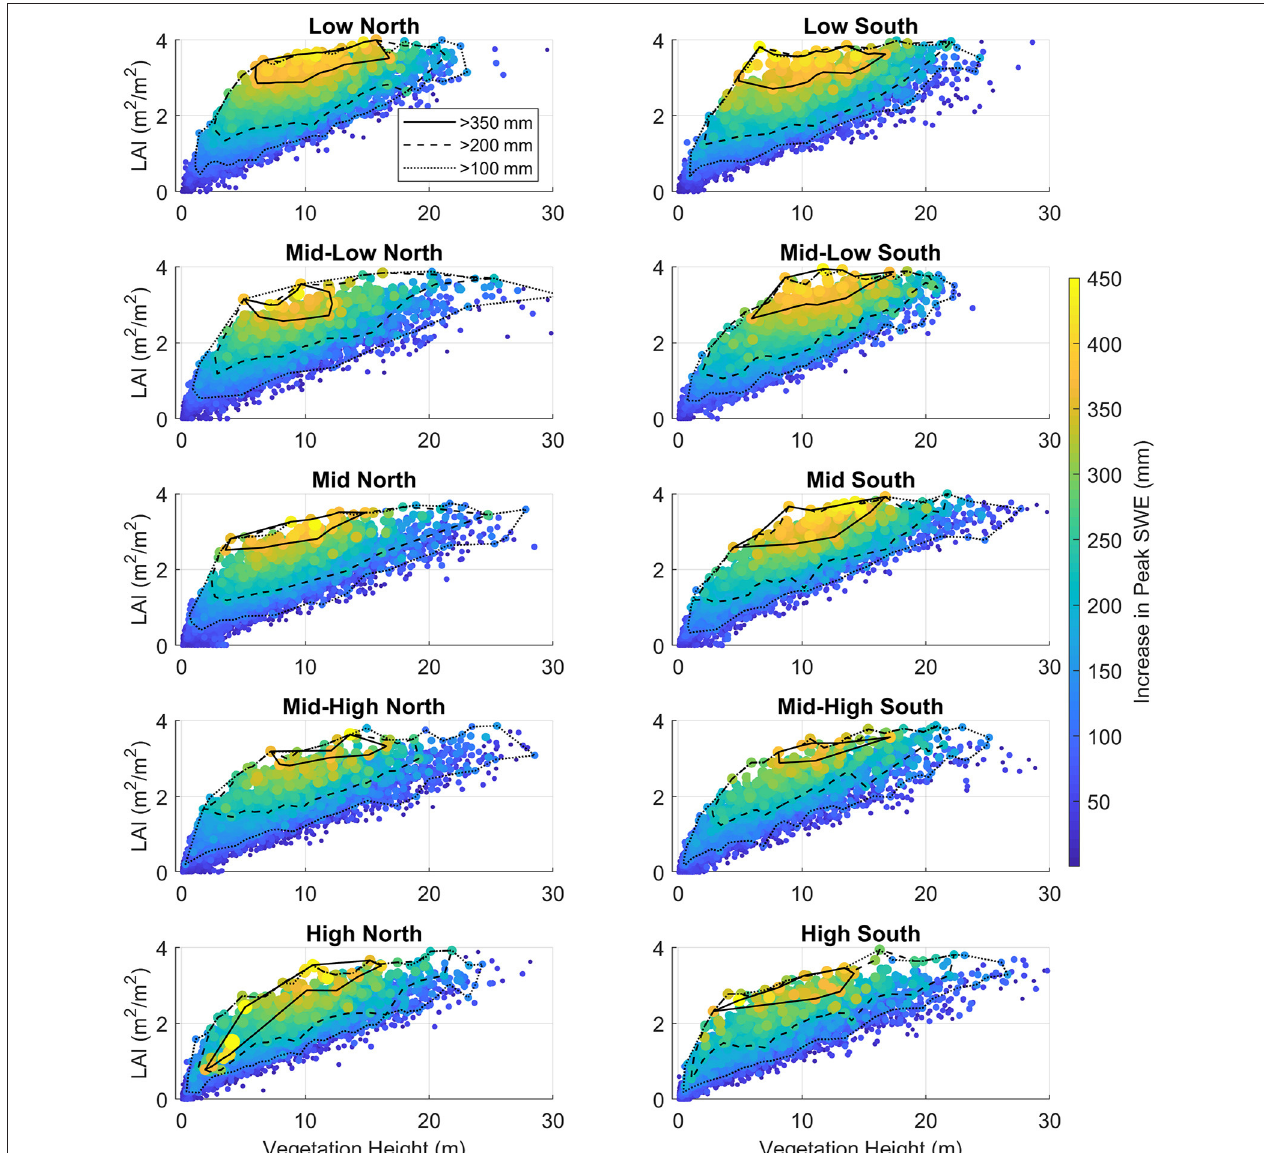
FIGURE 7 | Forest patch (30m) increase in peak SWE across Snow Zones for both thinning scenarios and organized by existing vegetation LAI and height. Dots are colored and sized according to increases in peak SWE. Continuous, dashed and pointed lines show the boundary of points with changes in melt volume > 350, 200, and 100mm,